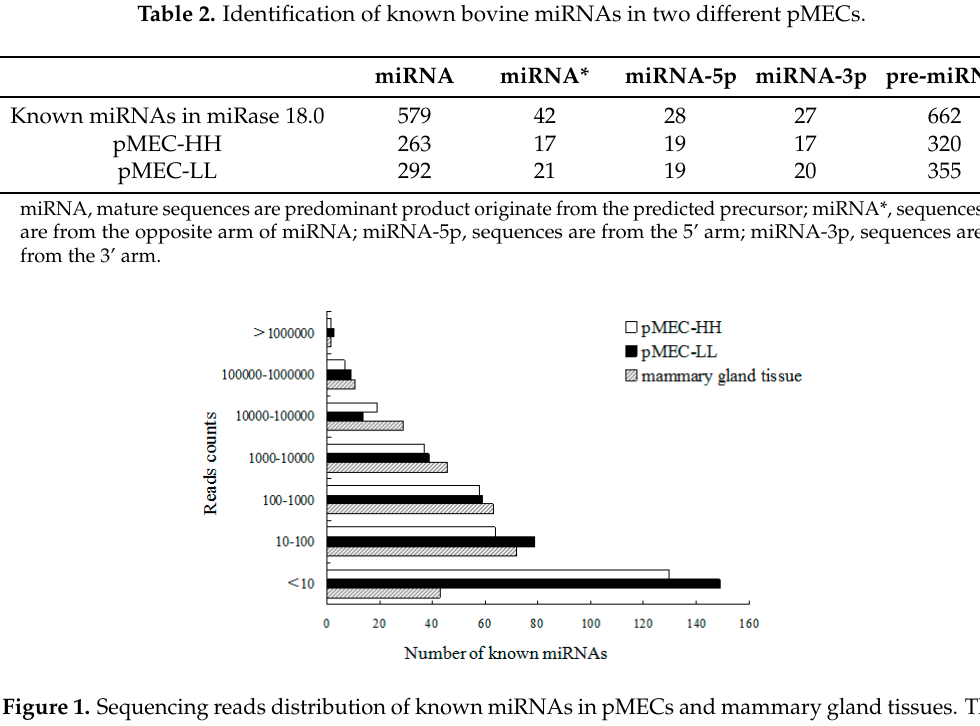
Table 2. Identification of known bovine miRNAs in two different pMECs.